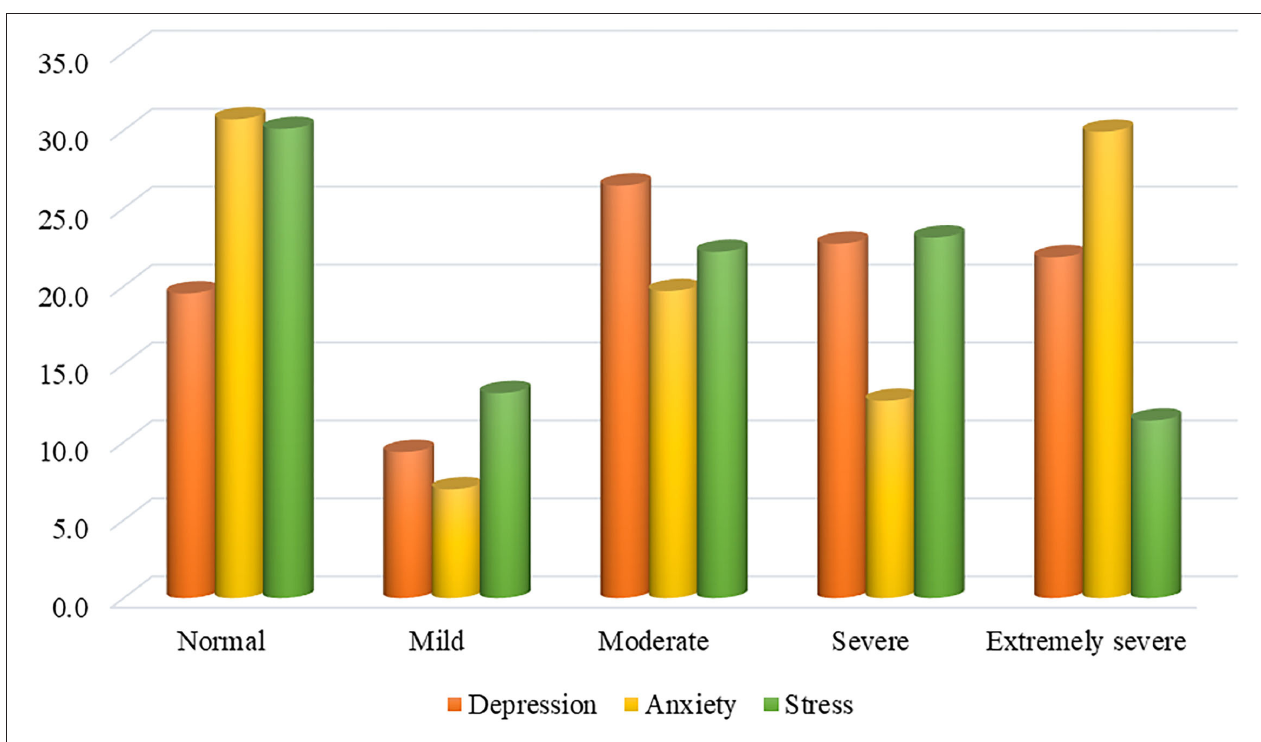
FIGURE 1 | Levels of mental health